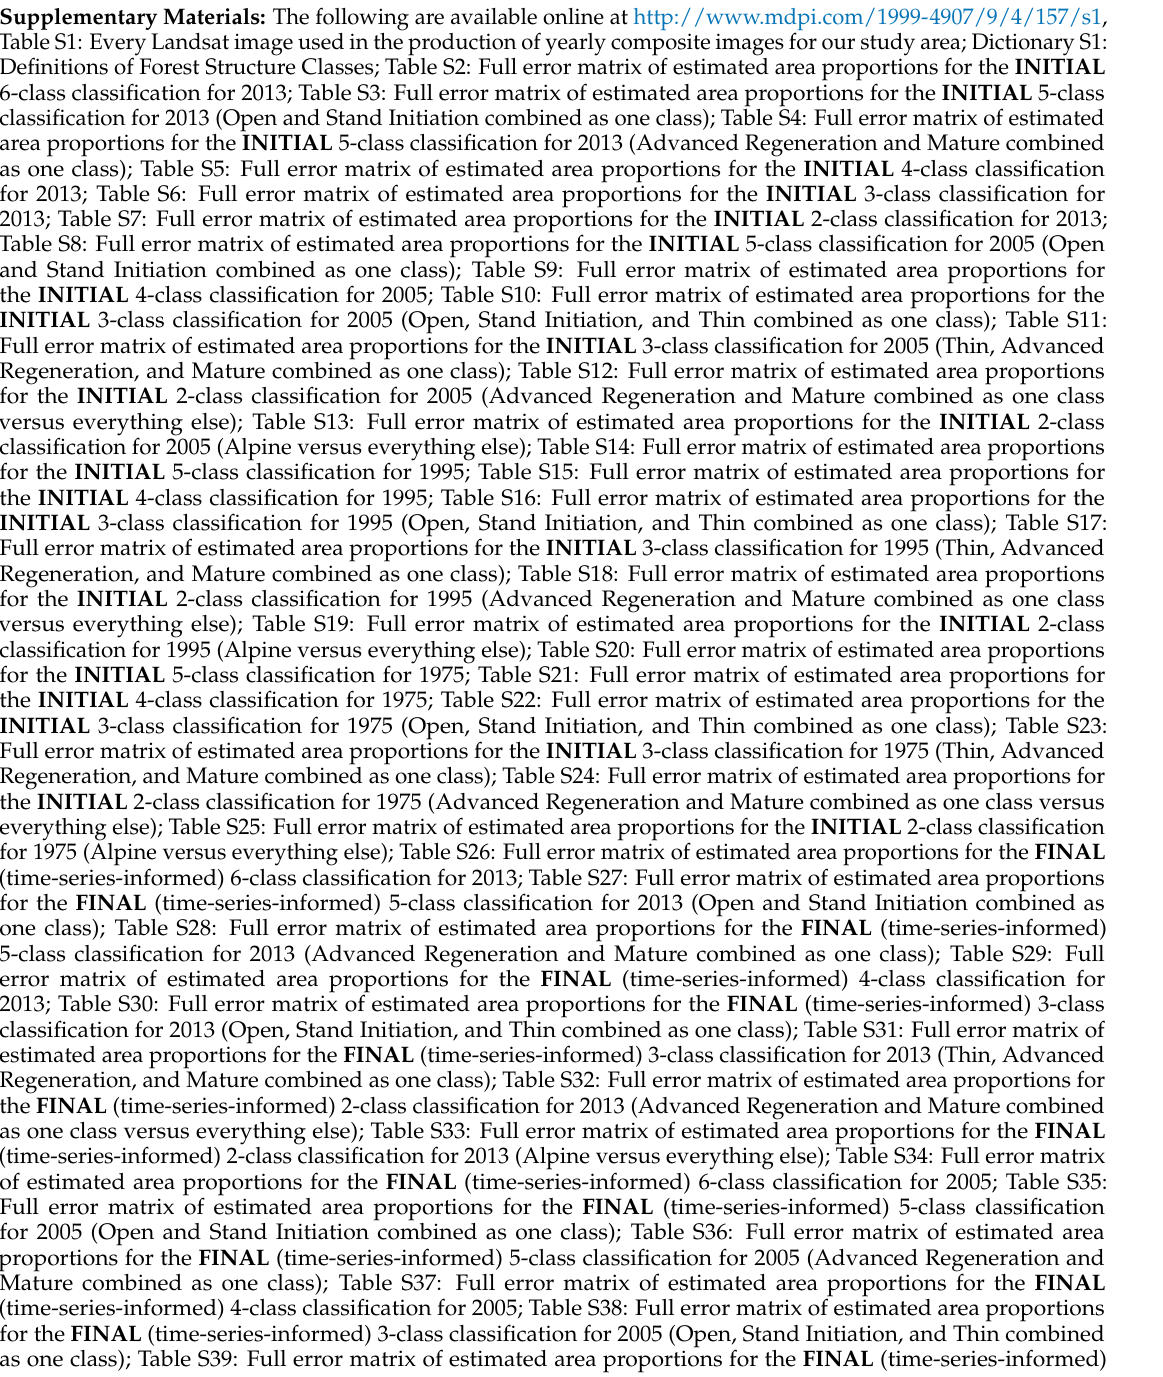
Table S1: Every Landsat image used in the production of yearly composite images for our study area; Dictionary S1: Definitions of Forest Structure Classes; Table S2: Full error matrix of estimated area proportions for the INITIAL 6-class classification for 2013; Table S3: Full error matrix of estimated area proportions for the INITIAL 5-class classification for 2013 (Open and Stand Initiation combined as one class); Table S4: Full error matrix of estimated area proportions for the INITIAL 5-class classification for 2013 (Advanced Regeneration and Mature combined as one class); Table S5: Full error matrix of estimated area proportions for the INITIAL 4-class classification for 2013; Table S6: Full error matrix of estimated area proportions for the INITIAL 3-class classification for 2013; Table S7: Full error matrix of estimated area proportions for the INITIAL 2-class classification for 2013; Table S8: Full error matrix of estimated area proportions for the INITIAL 5-class classification for 2005 (Open and Stand Initiation combined as one class); Table S9: Full error matrix of estimated area proportions for the INITIAL 4-class classification for 2005; Table S10: Full error matrix of estimated area proportions for the INITIAL 3-class classification for 2005 (Open, Stand Initiation, and Thin combined as one class); Table S11: Full error matrix of estimated area proportions for the INITIAL 3-class classification for 2005 (Thin, Advanced Regeneration, and Mature combined as one class); Table S12: Full error matrix of estimated area proportions for the INITIAL 2-class classification for 2005 (Advanced Regeneration and Mature combined as one class versus everything else); Table S13: Full error matrix of estimated area proportions for the INITIAL 2-class classification for 2005 (Alpine versus everything else); Table S14: Full error matrix of estimated area proportions for the INITIAL 5-class classification for 1995; Table S15: Full error matrix of estimated area proportions for the INITIAL 4-class classification for 1995; Table S16: Full error matrix of estimated area proportions for the INITIAL 3-class classification for 1995 (Open, Stand Initiation, and Thin combined as one class); Table S17: Full error matrix of estimated area proportions for the INITIAL 3-class classification for 1995 (Thin, Advanced Regeneration, and Mature combined as one class); Table S18: Full error matrix of estimated area proportions for the INITIAL 2-class classification for 1995 (Advanced Regeneration and Mature combined as one class versus everything else); Table S19: Full error matrix of estimated area proportions for the INITIAL 2-class classification for 1995 (Alpine versus everything else); Table S20: Full error matrix of estimated area proportions for the INITIAL 5-class classification for 1975; Table S21: Full error matrix of estimated area proportions for the INITIAL 4-class classification for 1975; Table S22: Full error matrix of estimated area proportions for the INITIAL 3-class classification for 1975 (Open, Stand Initiation, and Thin combined as one class); Table S23: Full error matrix of estimated area proportions for the INITIAL 3-class classification for 1975 (Thin, Advanced Regeneration, and Mature combined as one class); Table S24: Full error matrix of estimated area proportions for the INITIAL 2-class classification for 1975 (Advanced Regeneration and Mature combined as one class versus everything else); Table S25: Full error matrix of estimated area proportions for the INITIAL 2-class classification for 1975 (Alpine versus everything else); Table S26: Full error matrix of estimated area proportions for the FINAL (time-series-informed) 6-class classification for 2013; Table S27: Full error matrix of estimated area proportions for the FINAL (time-series-informed) 5-class classification for 2013 (Open and Stand Initiation combined as one class); Table S28: Full error matrix of estimated area proportions for the FINAL (time-series-informed) 5-class classification for 2013 (Advanced Regeneration and Mature combined as one class); Table S29: Full error matrix of estimated area proportions for the FINAL (time-series-informed) 4-class classification for 2013; Table S30: Full error matrix of estimated area proportions for the FINAL (time-series-informed) 3-class classification for 2013 (Open, Stand Initiation, and Thin combined as one class); Table S31: Full error matrix of estimated area proportions for the FINAL (time-series-informed) 3-class classification for 2013 (Thin, Advanced Regeneration, and Mature combined as one class); Table S32: Full error matrix of estimated area proportions for the FINAL (time-series-informed) 2-class classification for 2013 (Advanced Regeneration and Mature combined as one class versus everything else); Table S33: Full error matrix of estimated area proportions for the FINAL (time-series-informed) 2-class classification for 2013 (Alpine versus everything else); Table S34: Full error matrix of estimated area proportions for the FINAL (time-series-informed) 6-class classification for 2005; Table S35: Full error matrix of estimated area proportions for the FINAL (time-series-informed) 5-class classification for 2005 (Open and Stand Initiation combined as one class); Table S36: Full error matrix of estimated area proportions for the FINAL (time-series-informed) 5-class classification for 2005 (Advanced Regeneration and Mature combined as one class); Table S37: Full error matrix of estimated area proportions for the FINAL (time-series-informed) 4-class classification for 2005; Table S38: Full error matrix of estimated area proportions for the FINAL (time-series-informed) 3-class classification for 2005 (Open, Stand Initiation, and Thin combined as one class); Table S39: Full error matrix of estimated area proportions for the FINAL